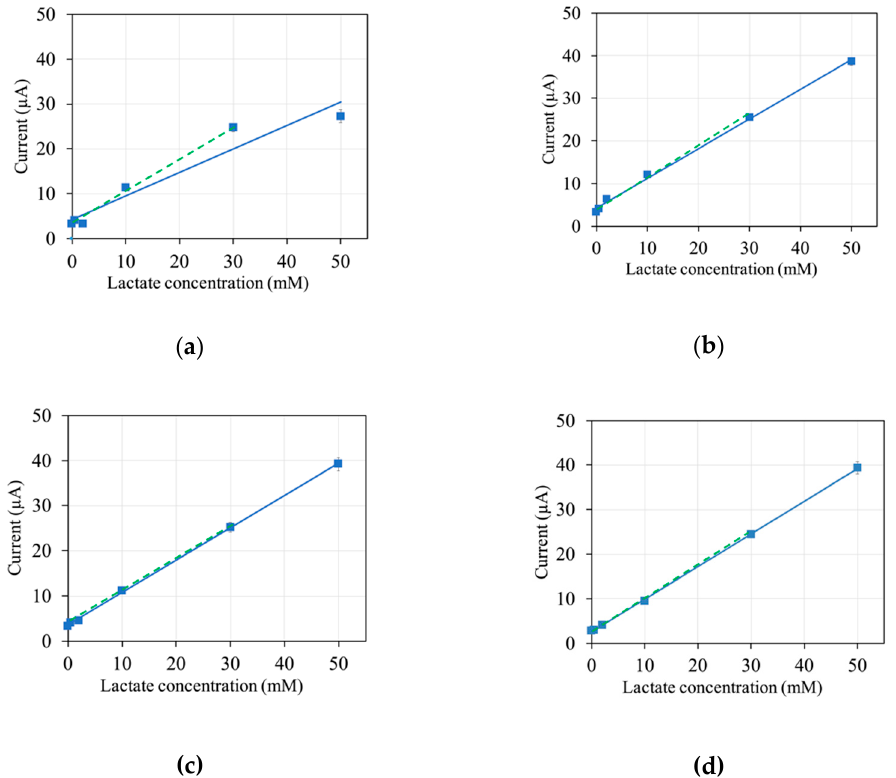
Figure 3. Response currents at different application potentials: ( a ) 0 V, ( b ) +0.05 V, ( c ) +0.1 V, and ( d ) +0.2 V vs. Ag/AgCl. Blue continuous line: linear regression for the range of up to 50 mM; green dashed line: linear regression for the range of up to 30 mM. Sensitivity for the range up to 50 mM: 0.52 μ A/mM (R 2 = 0.93) in ( a ) and 0.69–0.73 μ A/mM (R 2 > 0.99) in ( b ‒ d ). Sensitivity for the range up to 30 mM: 0.69–0.73 μ A/mM (R 2 > 0.99) in ( a – d ). Sensor composition: 1 U Av LOx A96L, 100 nmol mPES, 40 μ g sucrose,